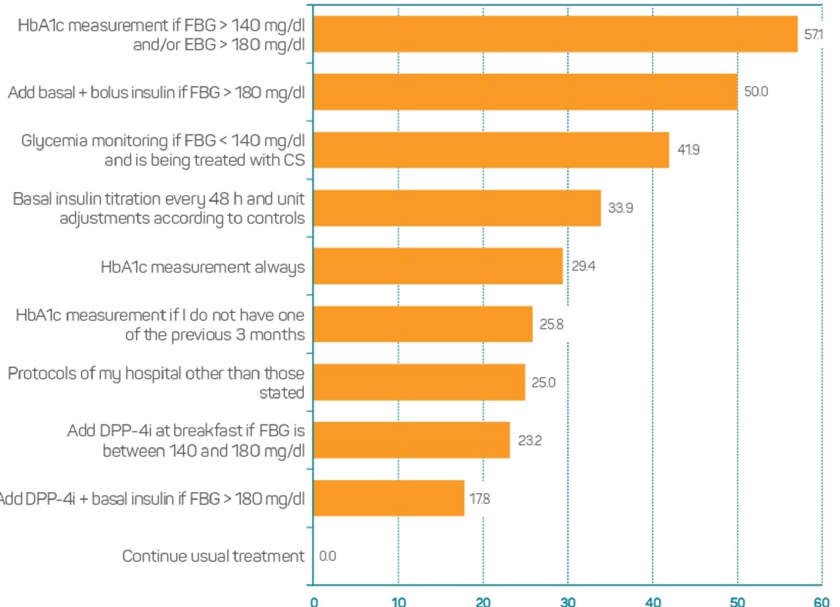
Figure 3. Opinion on therapeutic management of patients with unknown T2DM admitted to hospital due to COVID-19, who presented with hyperglycemia and did not require corticosteroids ( n = 112. CS, Corticosteroids; DPP-4i, Dipeptidyl peptidase 4 inhibitors; EBG, evening blood glucose; FBG, fasting blood glucose; HbA1c, Glycated haemoglobin.